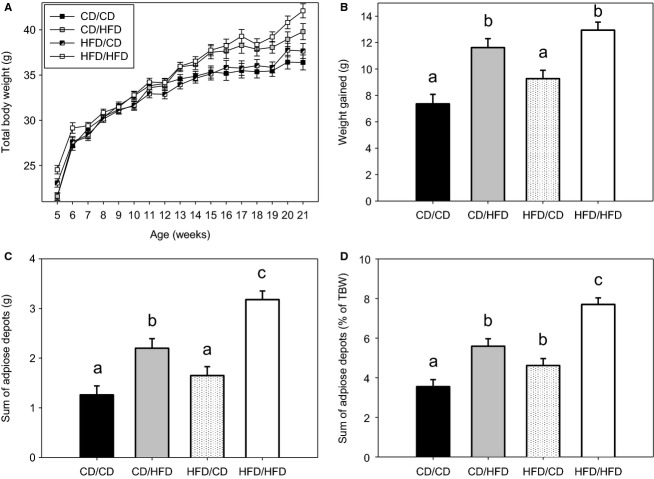
Total body weight and adiposity of F1 male offspring fed a CD/HFD fathered by CD/HFD F0 males. (A) Total body weight during the dietary challenge, (B) total weight gained during the dietary challenge, sum of adipose depots dissected postmortem upon completion of the dietary challenge expressed in both (C) absolute terms and (D) as a proportion of total body weight are depicted for F1 males for the groups CD/CD (CD fed F1 sired by a CD fed F0; n = 14), CD/HFD (HFD fed F1 sired by a CD fed F0; n = 14), HFD/CD (CD fed F1 sired by a HFD fed F0; n = 20) and HFD/HFD (HFD fed F1 sired by a HFD fed F0; n = 19). Data are presented as means ± SEM and different letters represent statistically distinct groups (P < 0.05).